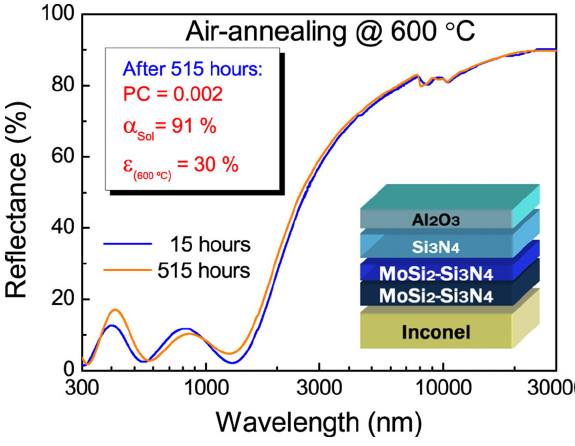
Fig. 5: Reflectance of new coating from Ref. [91]. Reprinted from So- lar Energy Materials and Solar Cells, Vol. 174, Rodríguez-Palomo, A., Céspedes, E., Hernández-Pinilla, D. and Prieto, C., High- temperature air-stable solar selective coating based on MoSi 2–Si 3 N 4 composite, Pages No. 50-55, Copyright (2018), with permission from